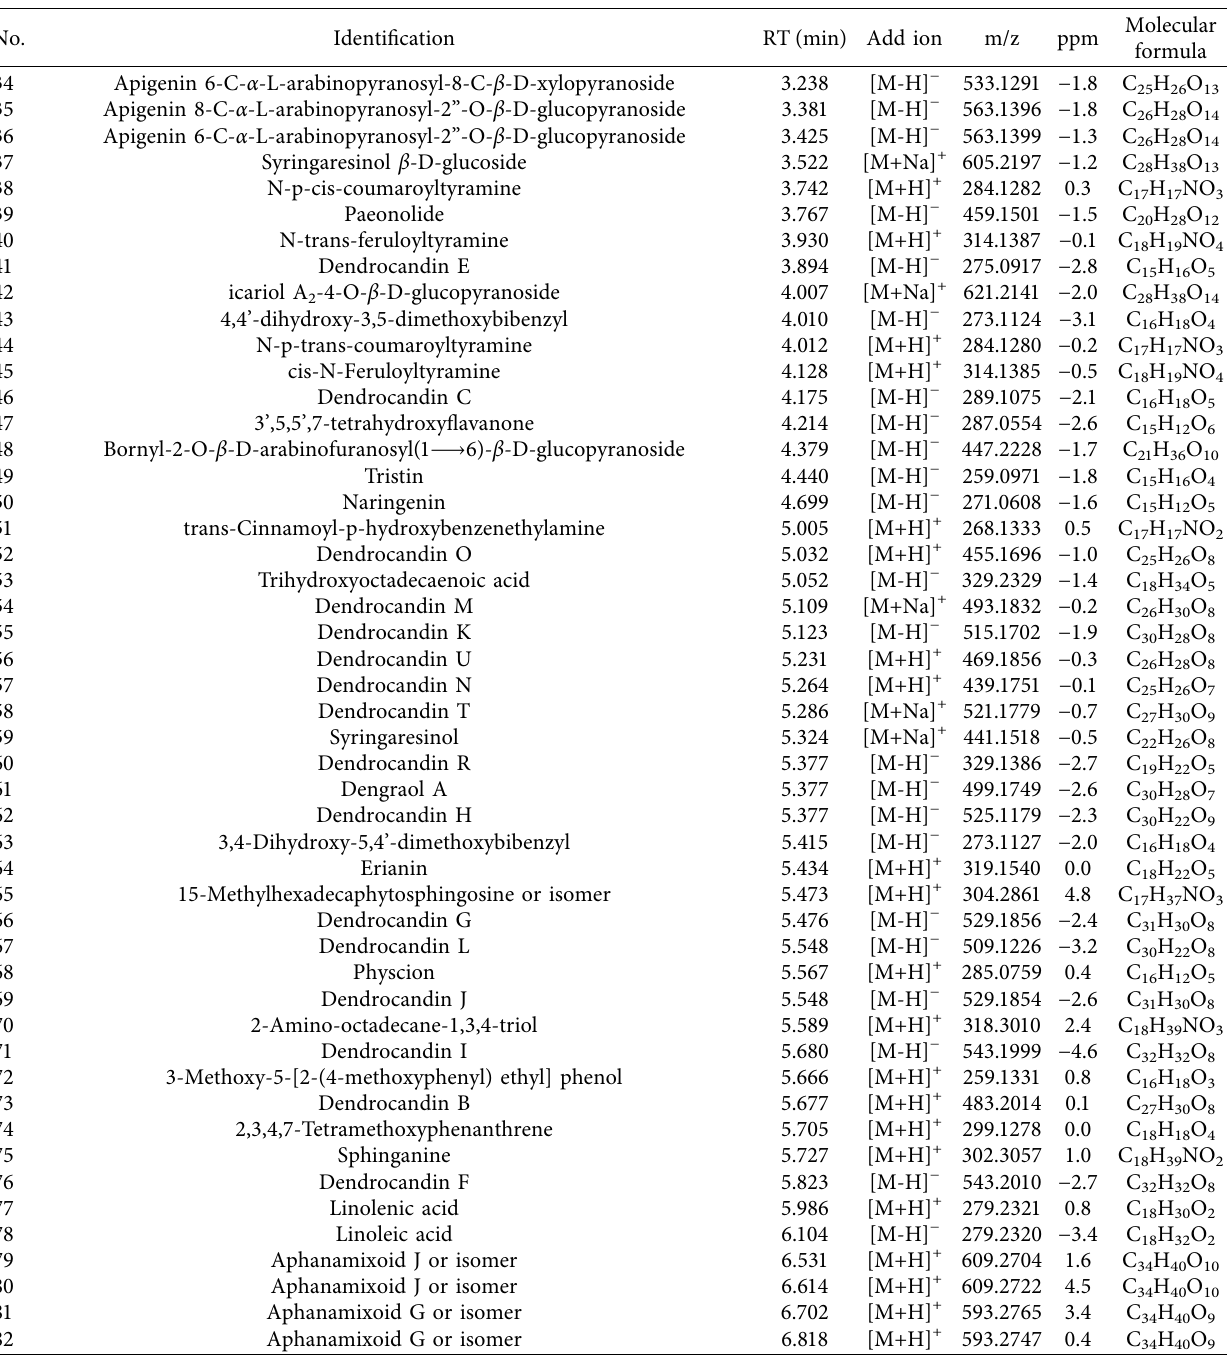
arabinopyranosyl-2”-O- β -D-glucopyranoside: F8, apigenin 6-C- α -L-arabinopyranosyl-2”-O- β -D-glucopyranoside: F9), 3 organic nitrogenous compounds (succinylcarnitine: O1, O-methylmalonyl-L-carnitine: O2, O-glutaroyl-L-carnitine: O3), 5 phenolic glycosides (di-O-methylcrenatin: P1, 2,6- dihydroxybenzoic acid 2-O- β -D-apiofuranosyl-(1 ⟶